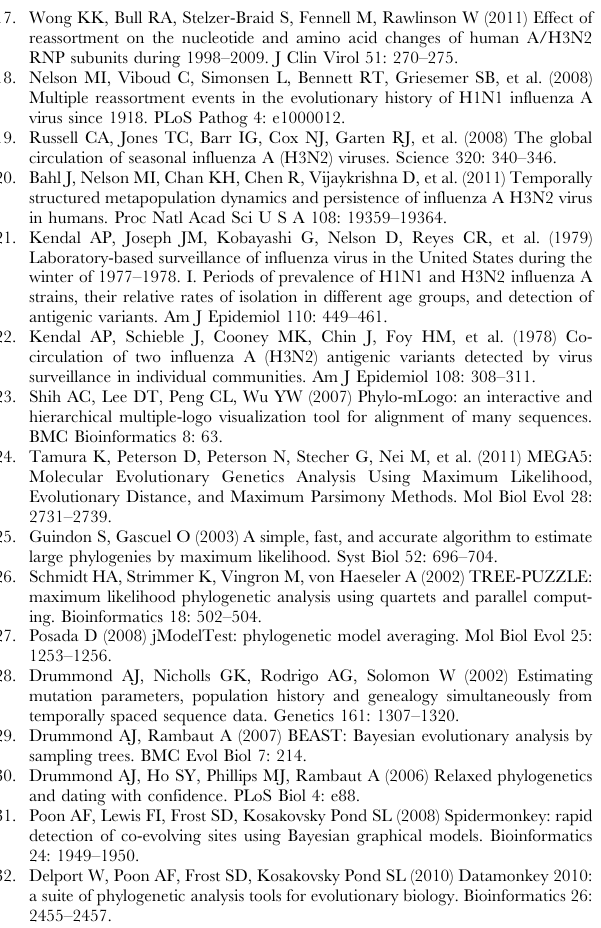
Figure S1 Weekly distribution of Taiwan influenza isolates,